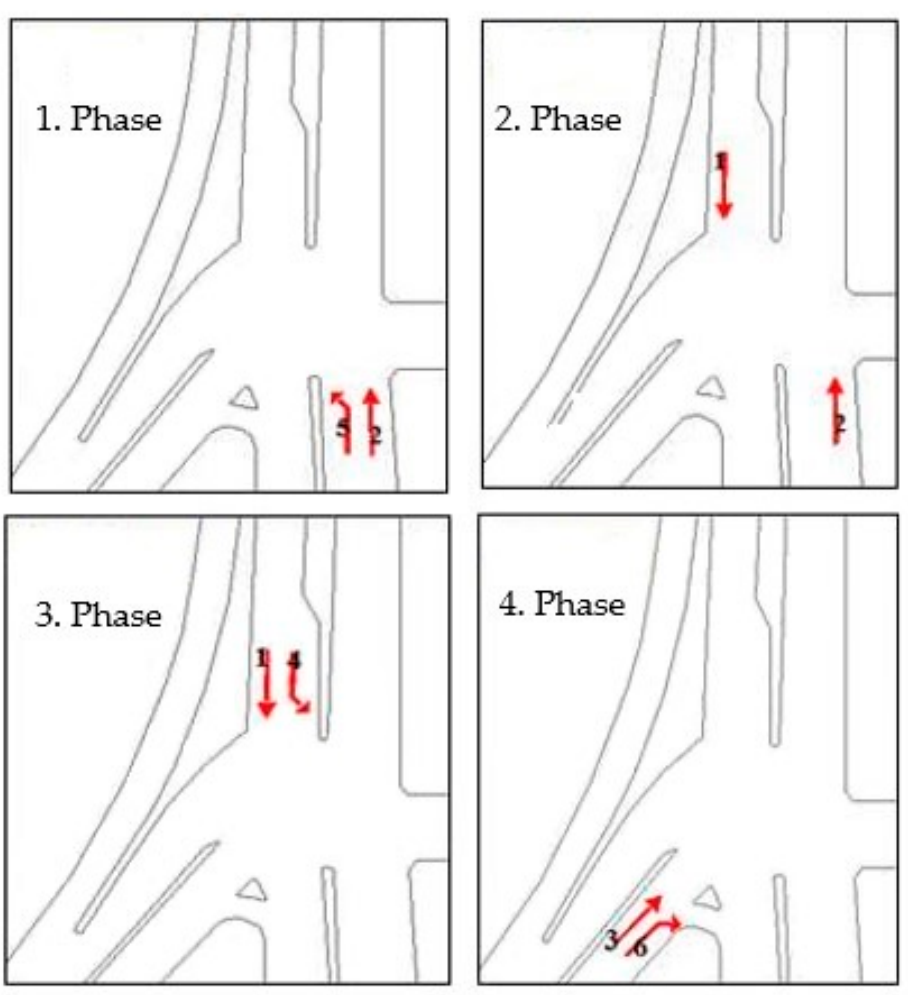
Figure 9. Phase transitions order of signal plans.